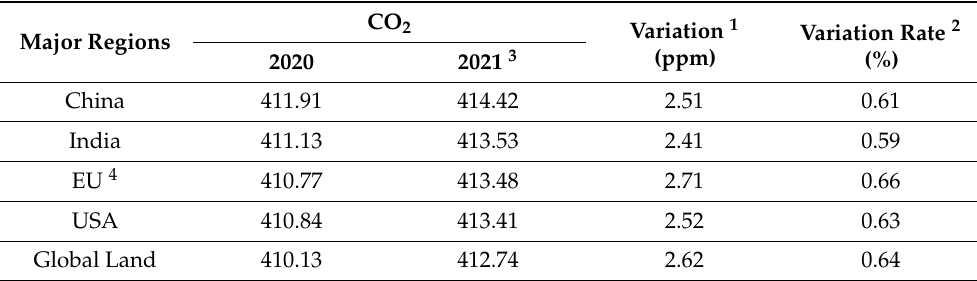
Table 1. Annual CO 2 concentrations and rates for global land and major countries/regions in 2020 and